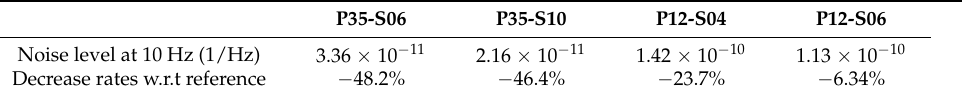
Figure 13. Comparison of low-frequency noise characteristics at 10 Hz of the a-Si microbolometers treated with the PMA process and the reference devices. Table 5. Low-frequency noise characteristics of the four types of a-Si microbolometers applied with the PMA process extracted at 10 Hz and the increase/decrease rate compared to the reference.